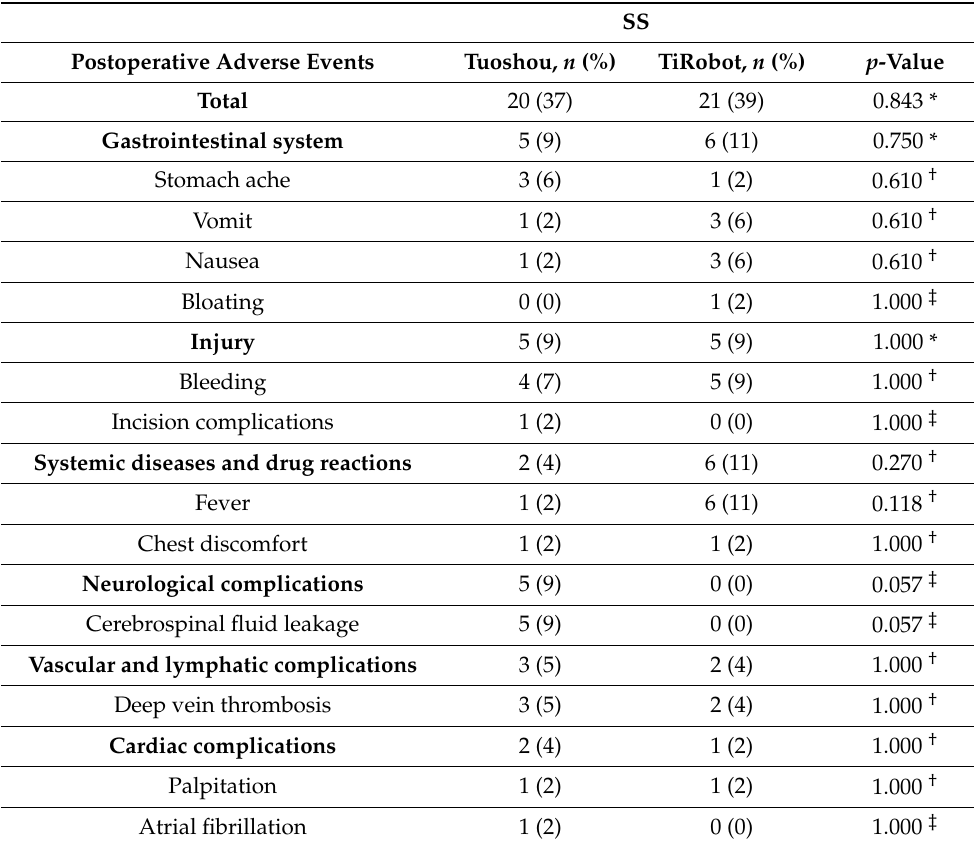
Table 6. Postoperative adverse events of two